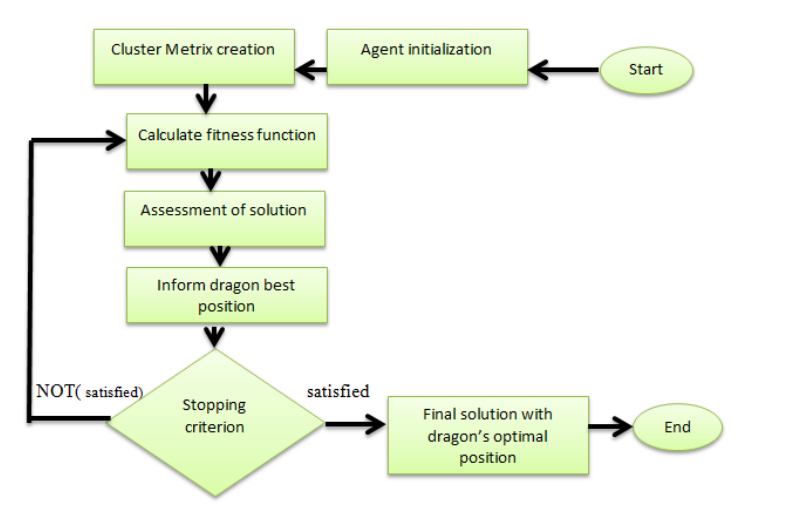
Figure 3. Flowchart of dragonfly (DF)